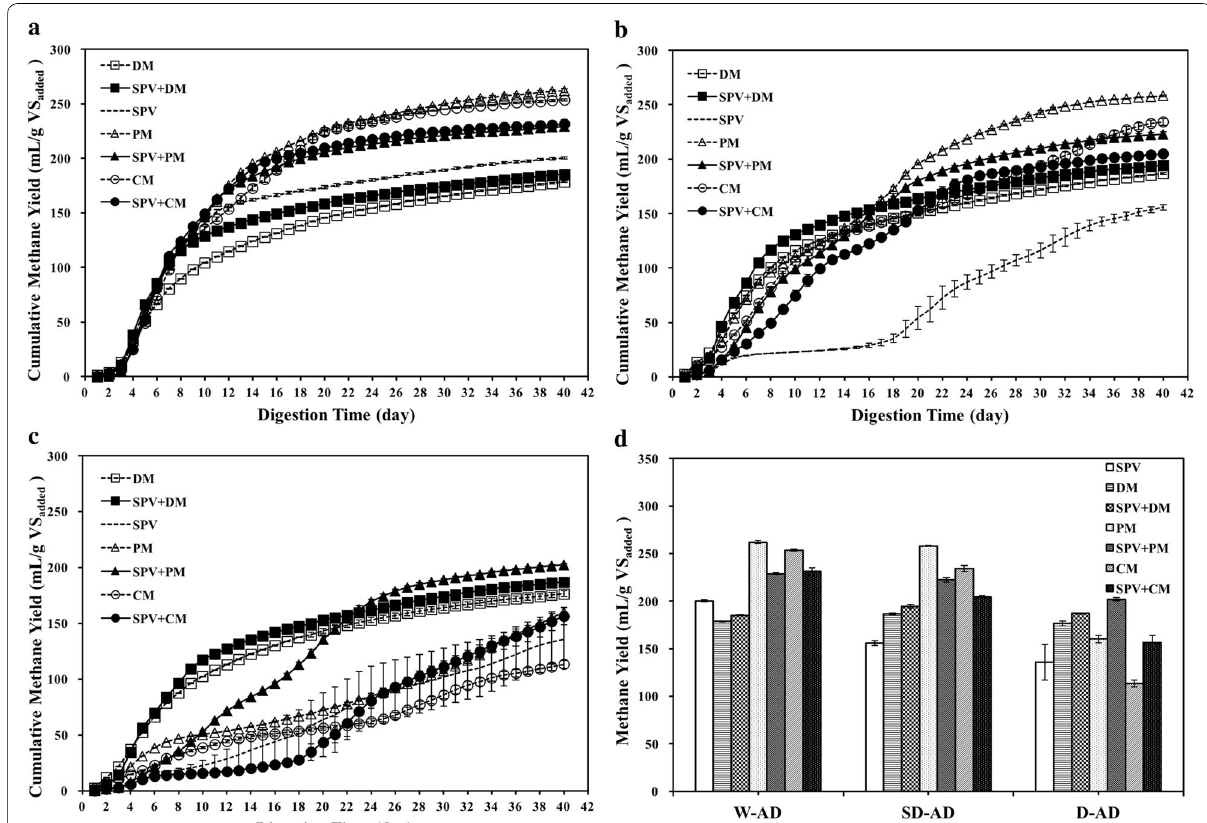
Fig. 2 Comparison of cumulative methane yield from SPV and the mixtures with animal manure in a W-AD, b SD-AD, c D-AD and d comparison of methane yield